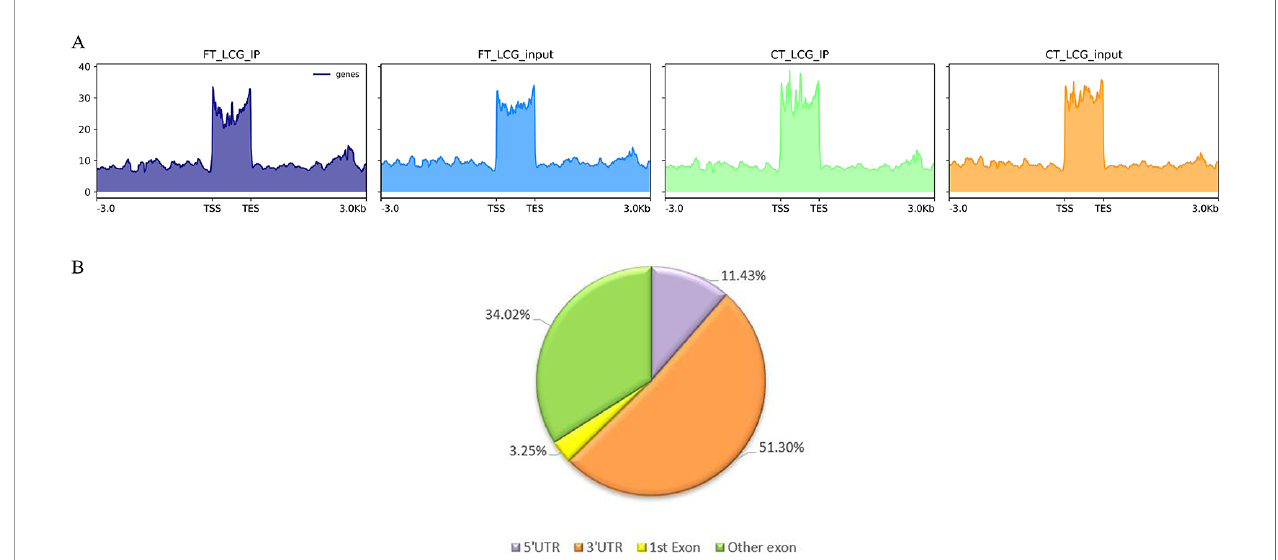
FIGURE 2 | (A) The enrichment of reads near TSS at the transcriptome initiation site of the gene. (B) The distribution of differential peaks on gene functional elements.